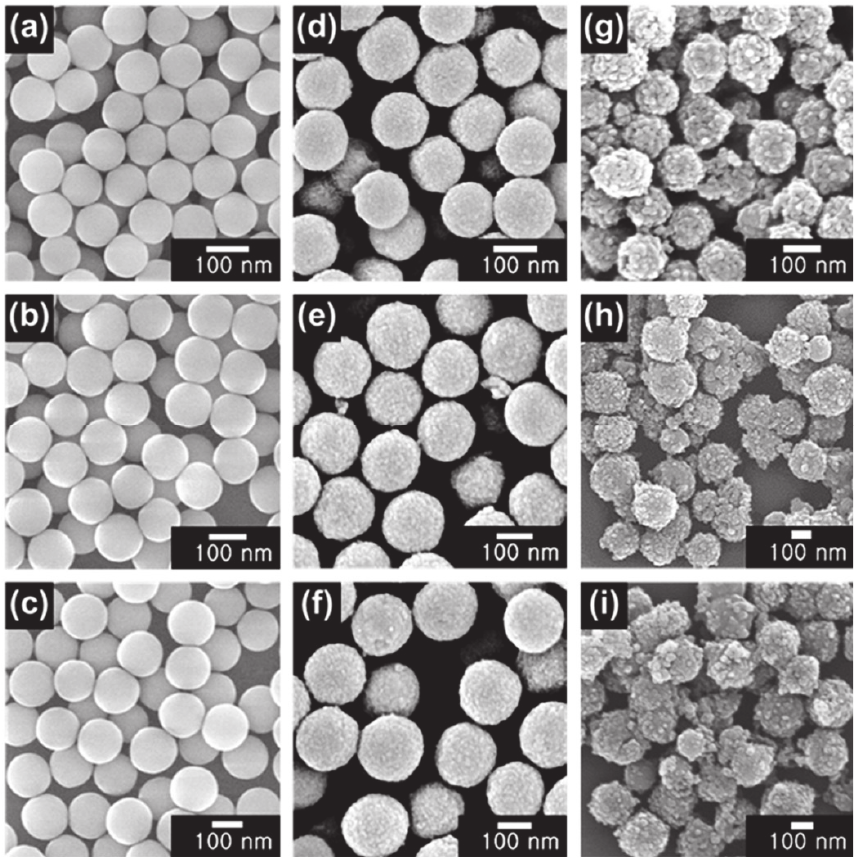
Figure 4. SEM images of ( a ) 100 nm SiO 2 , ( b ) 120 nm SiO 2 , ( c ) 140 nm SiO 2 , ( d ) 130 nm ST CSNs, ( e ) 160 nm ST CSNs, ( f ) 190 nm ST CSNs, ( g ) 140 nm SBT CSNs, ( h ) 170 nm SBT CSNs, and ( i ) 200 nm SBT CSNs.